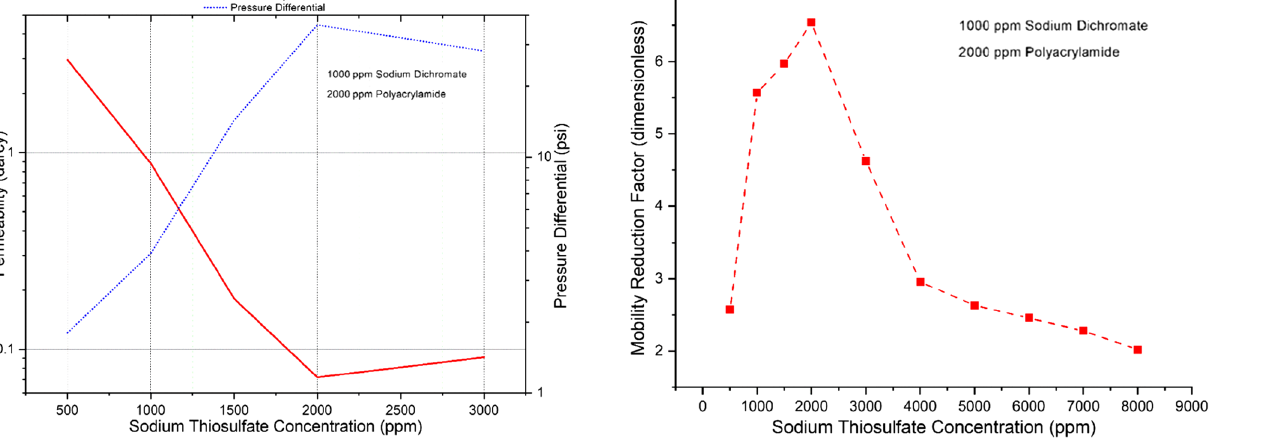
Fig. 6 Mobility reduction factor at different concentrations of Sodium thiosulfate under ambient conditions (24 °C and 14.7